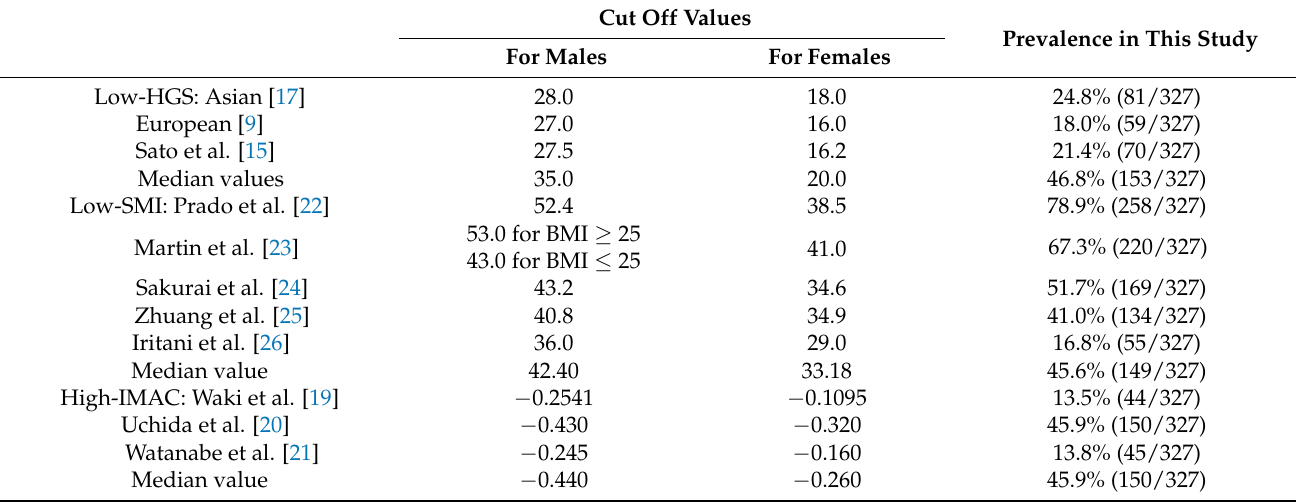
Table 1. Cut-off values used in this study and their